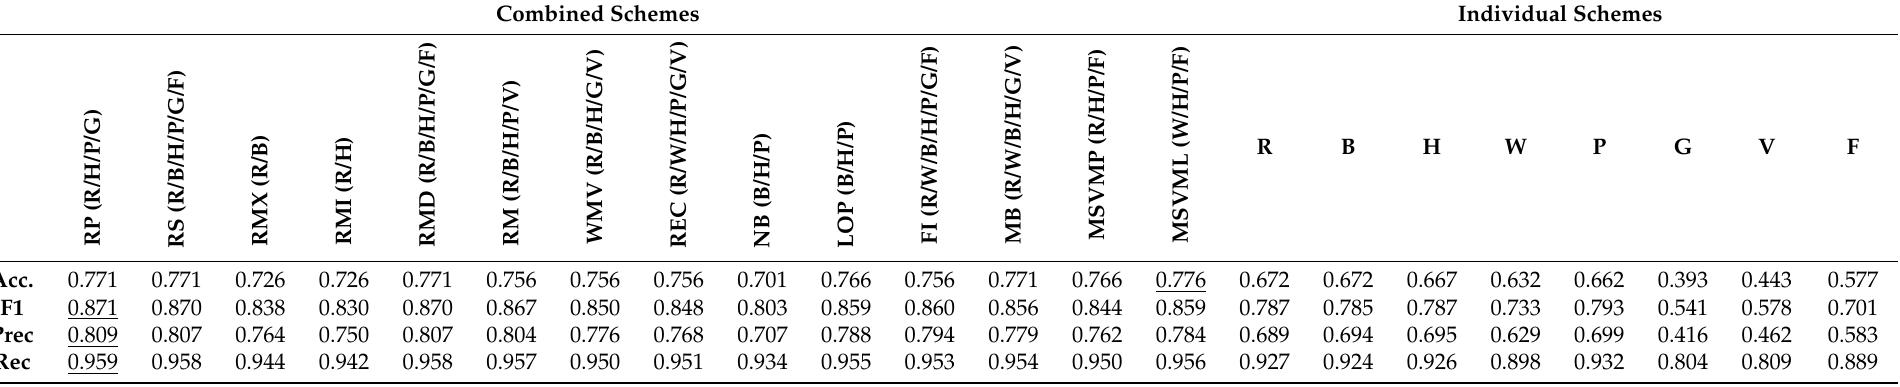
Table 8. The best schemes for each combination rule ( e · 1000 − 1 ) for the JAFFE data set. Acc: accuracy; Prec: precision; Rec: recall. Best classifier result is